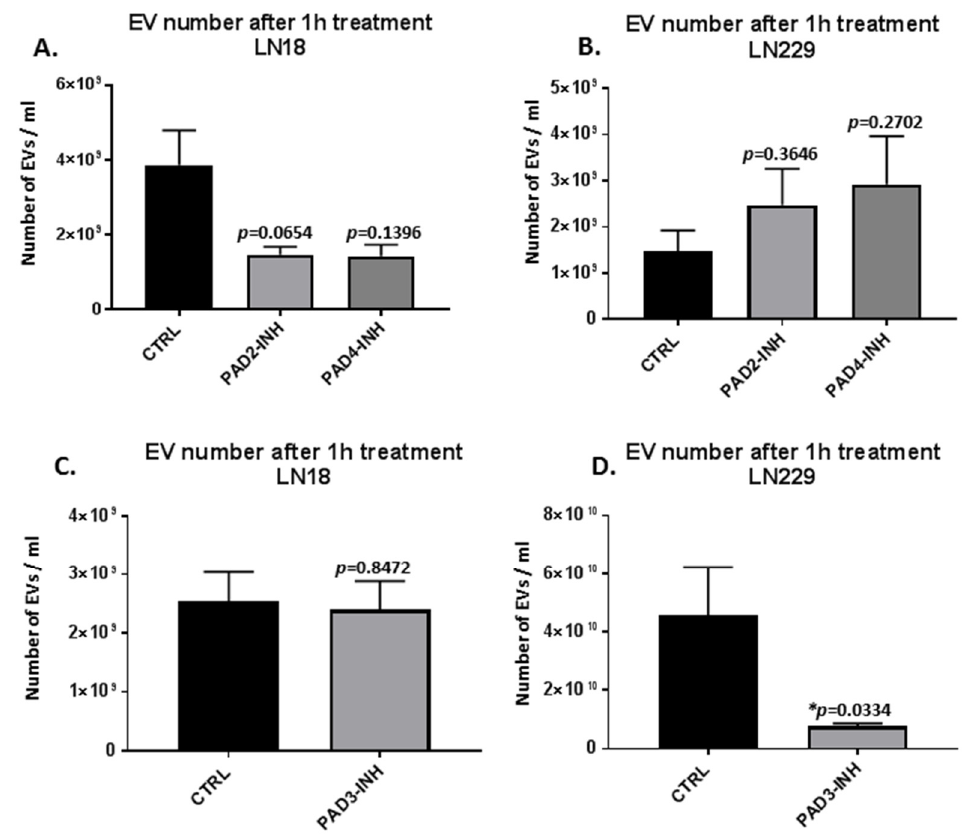
Figure 1. Peptidylarginine deiminase (PAD)2, PAD3 and PAD4 isozyme-specific inhibitor treatment shows glioblastoma multiforme (GBM) cancer cell line specific regulation of extracellular vesicle (EV) release. ( A ) Effects of PAD2 and PAD4 inhibitors on EV release in LN18 cells. ( B ) Effects of PAD2 and PAD4 inhibitors on EV release in LN229 cells. ( C ) Effects of PAD3 inhibitor on EV release in LN18 cells. ( D ) Effects of PAD3 inhibitor on EV release in LN229. ( D ). For each set of histograms, respectively, the PAD isozyme-specific inhibitor-treated and control-treated cells were run under the same experimental conditions. Exact p -values are indicated (* indicates significant differences with p < 0.05; n = 3 biological replicates for all).